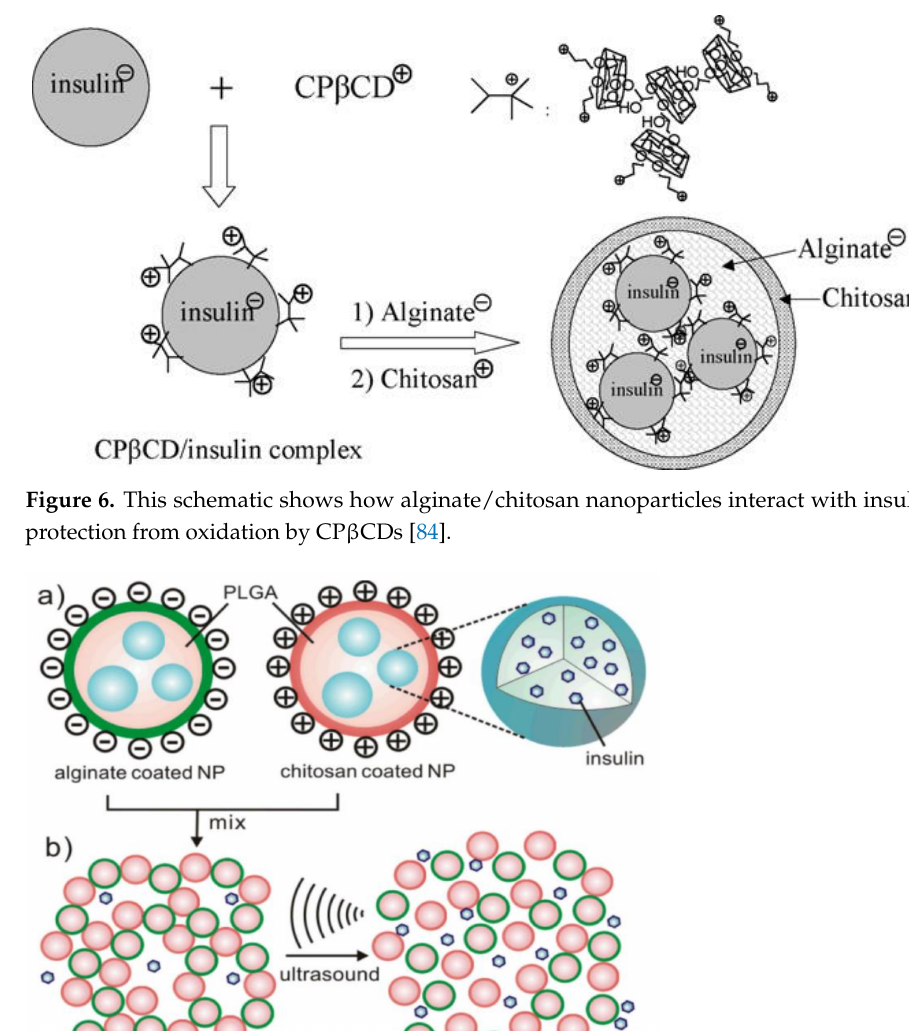
Figure 7. ( a ) Nanoparticles encapsulating insulin are embedded in PLGA and coated with alginate and chitosan. ( b ) A nano-network is formed by combining oppositely charged nanoparticles. It trig- gers the dissociation of the nano-network and promotes insulin release [85].